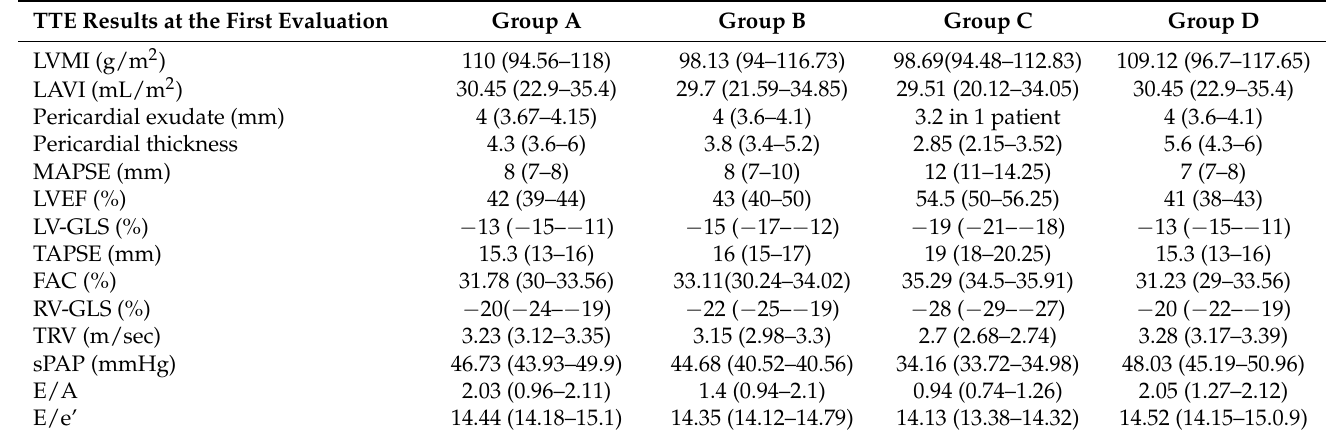
Table 2. Echocardiographic findings at the first evaluation.